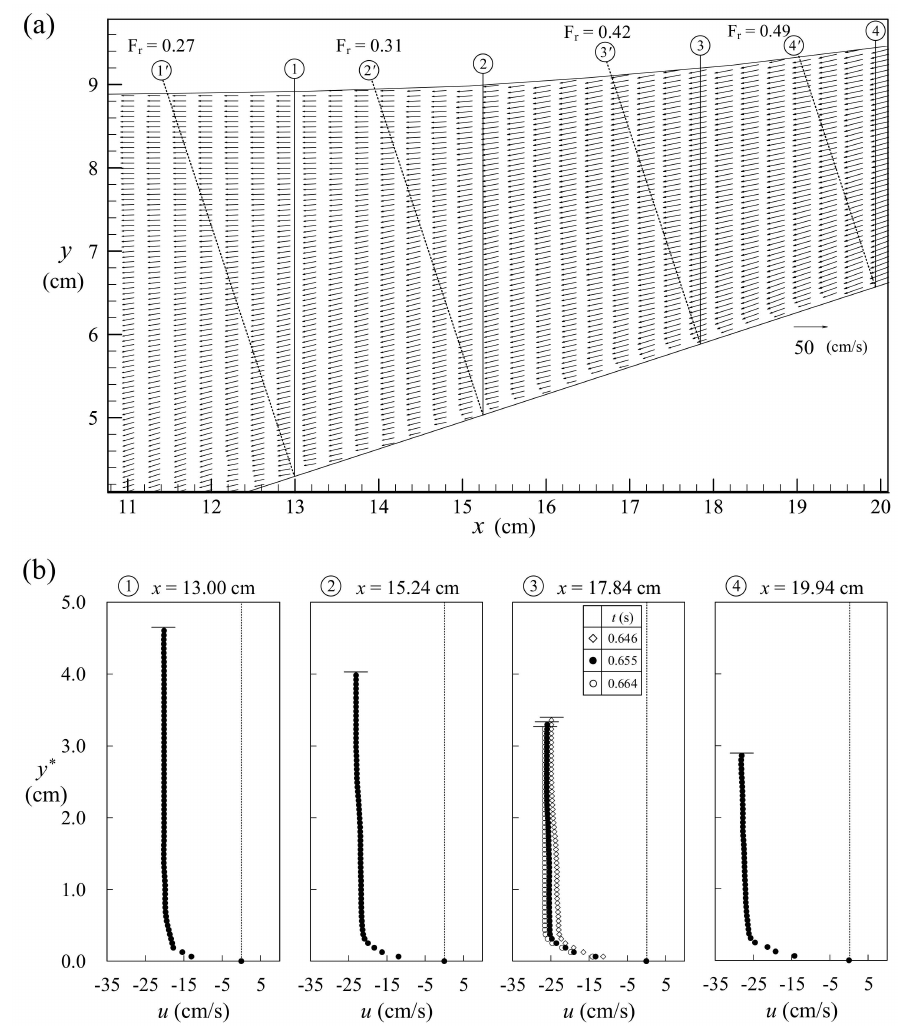
Figure 8. ( a ) Spatial variation of velocity field at t = 0.655 s; ( b ) velocity profiles, u ( y *), obtained at four different shoreward distances, x , as marked in ( a ) each with vertical line marked by circled number (Case 1). Note that the shifted height is denoted by y* = y − x